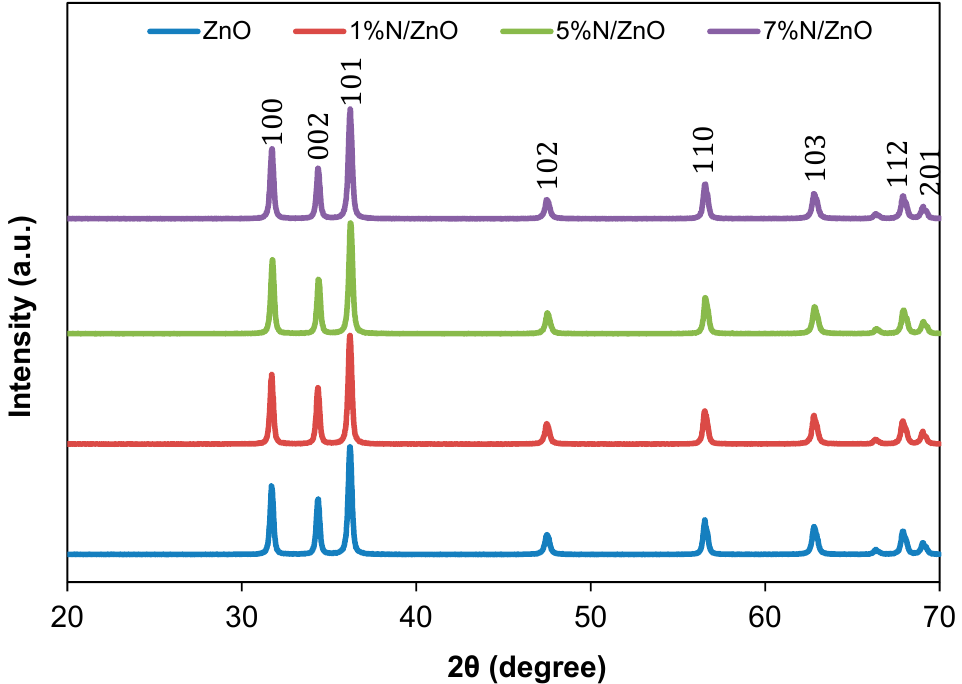
Figure 2. XRD patterns of undoped and N-doped ZnO nanocomposites.